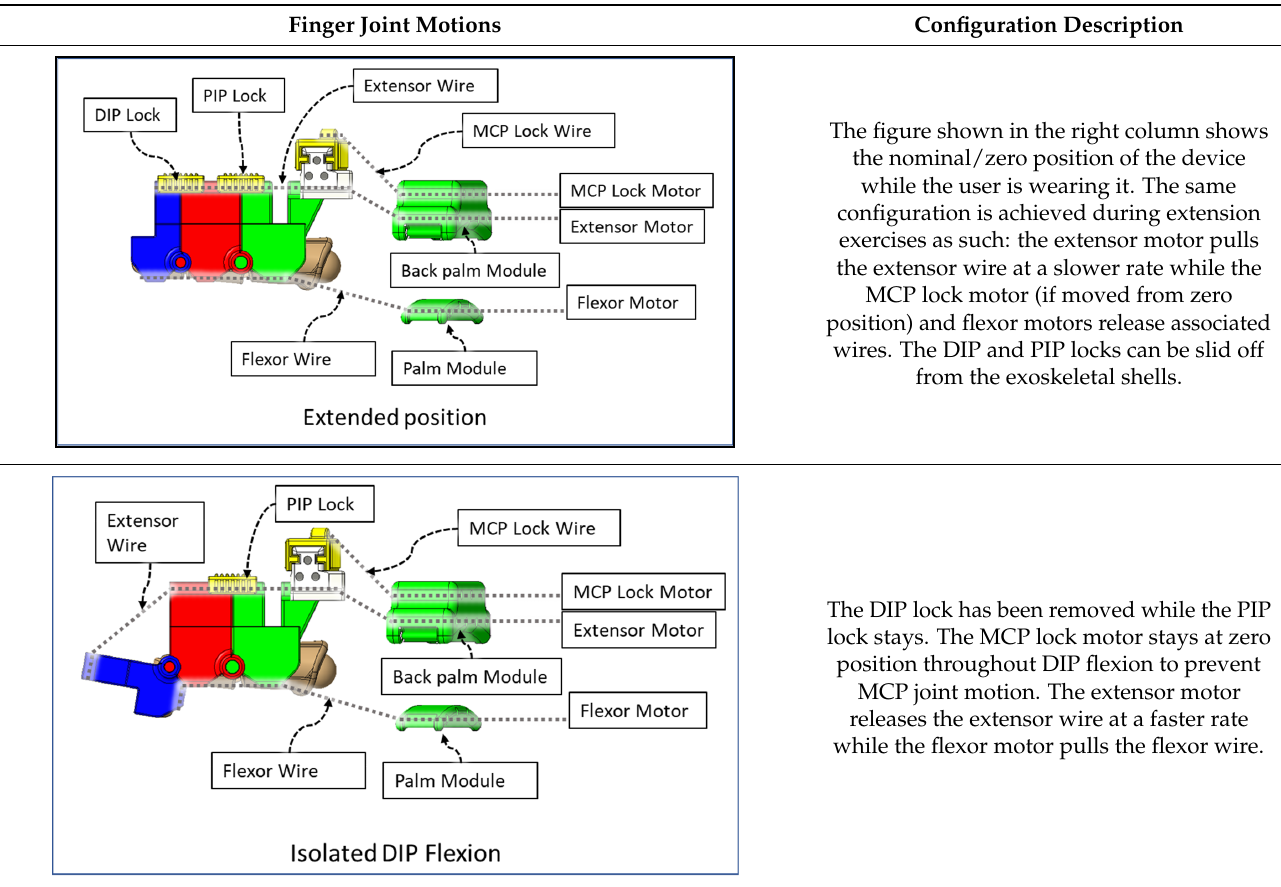
Table 2. Isolated and composite finger joint flexion–extension exercises.